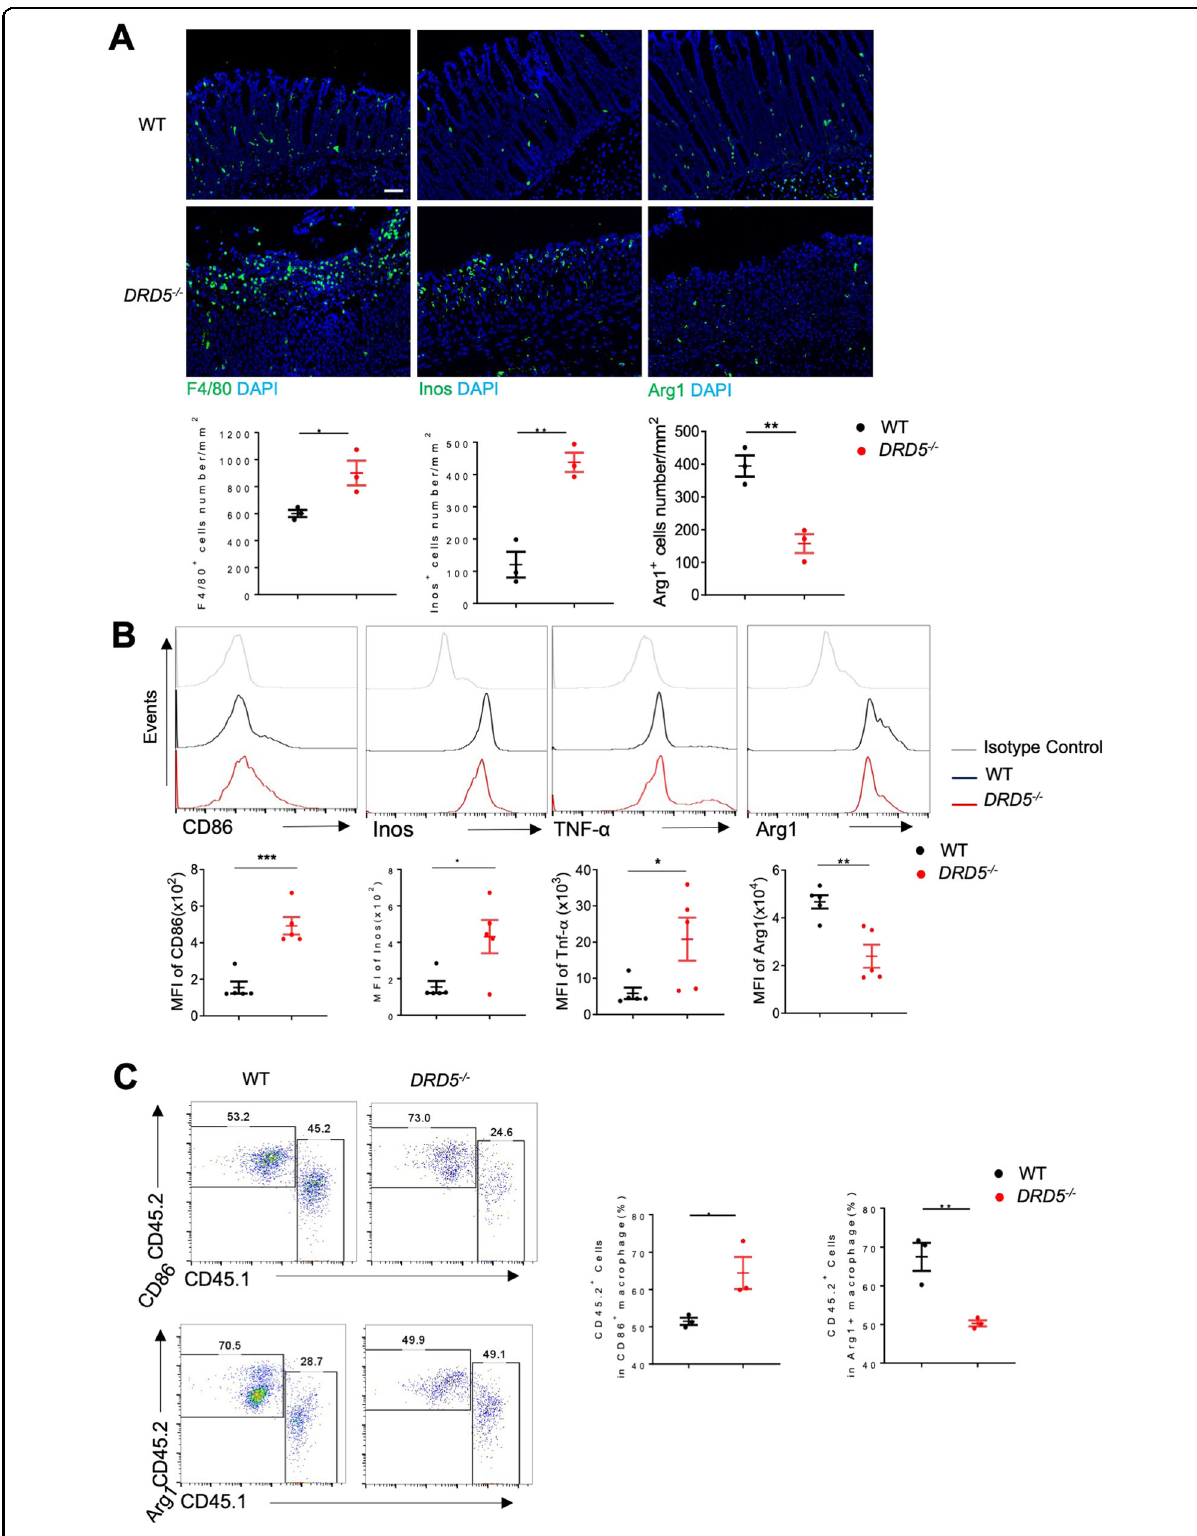
Fig. 5 (See legend on next